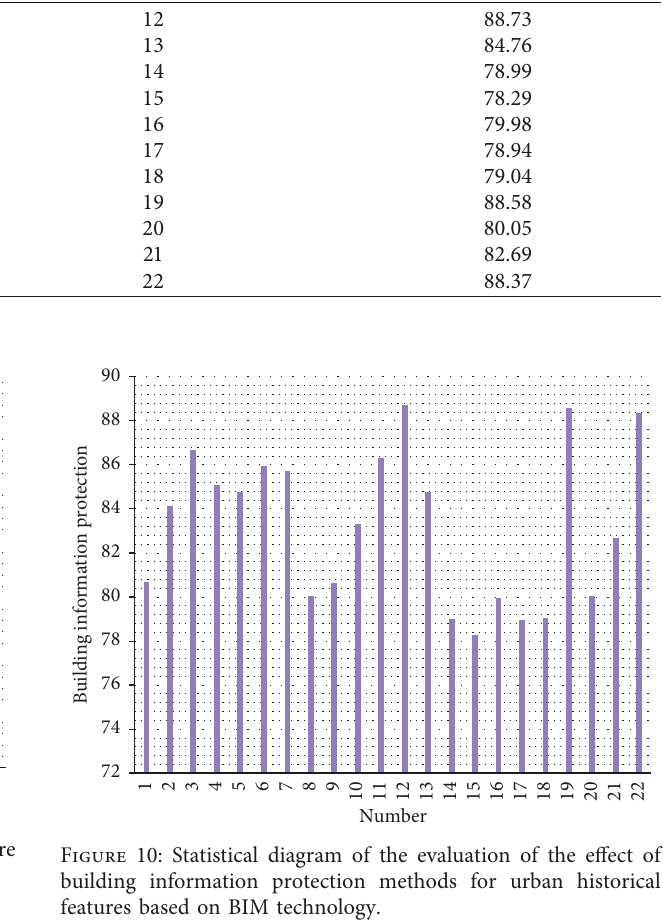
Table 2: Evaluation of the effect of building information protection methods of urban historical features based on BIM technology. Num